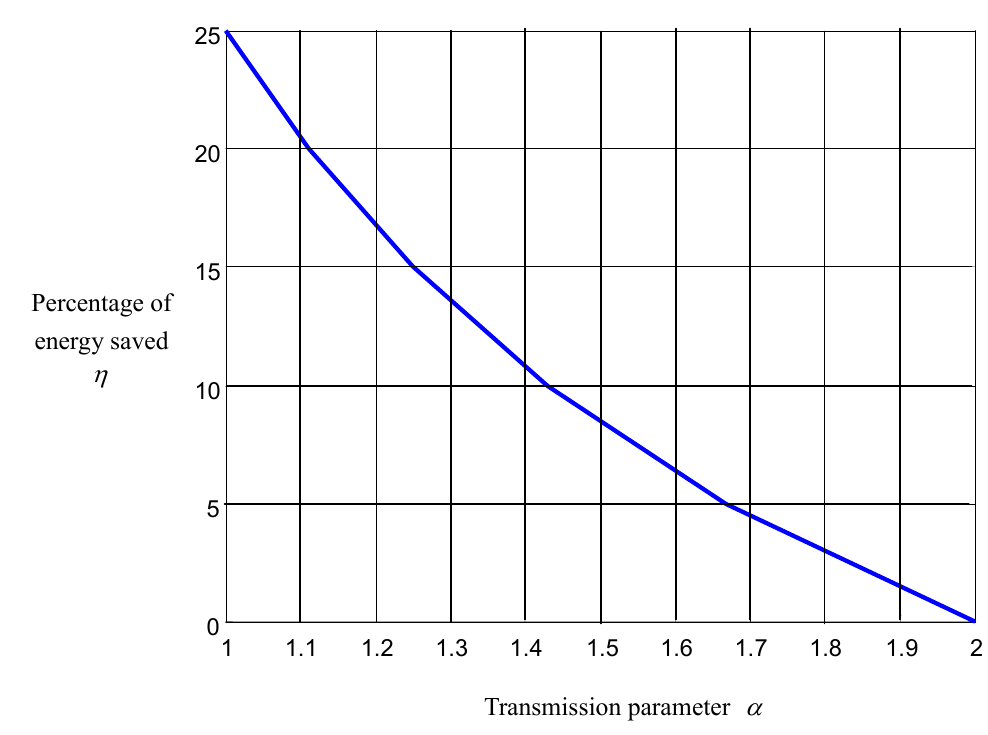
Figure 12. Energy saved versus negotiation